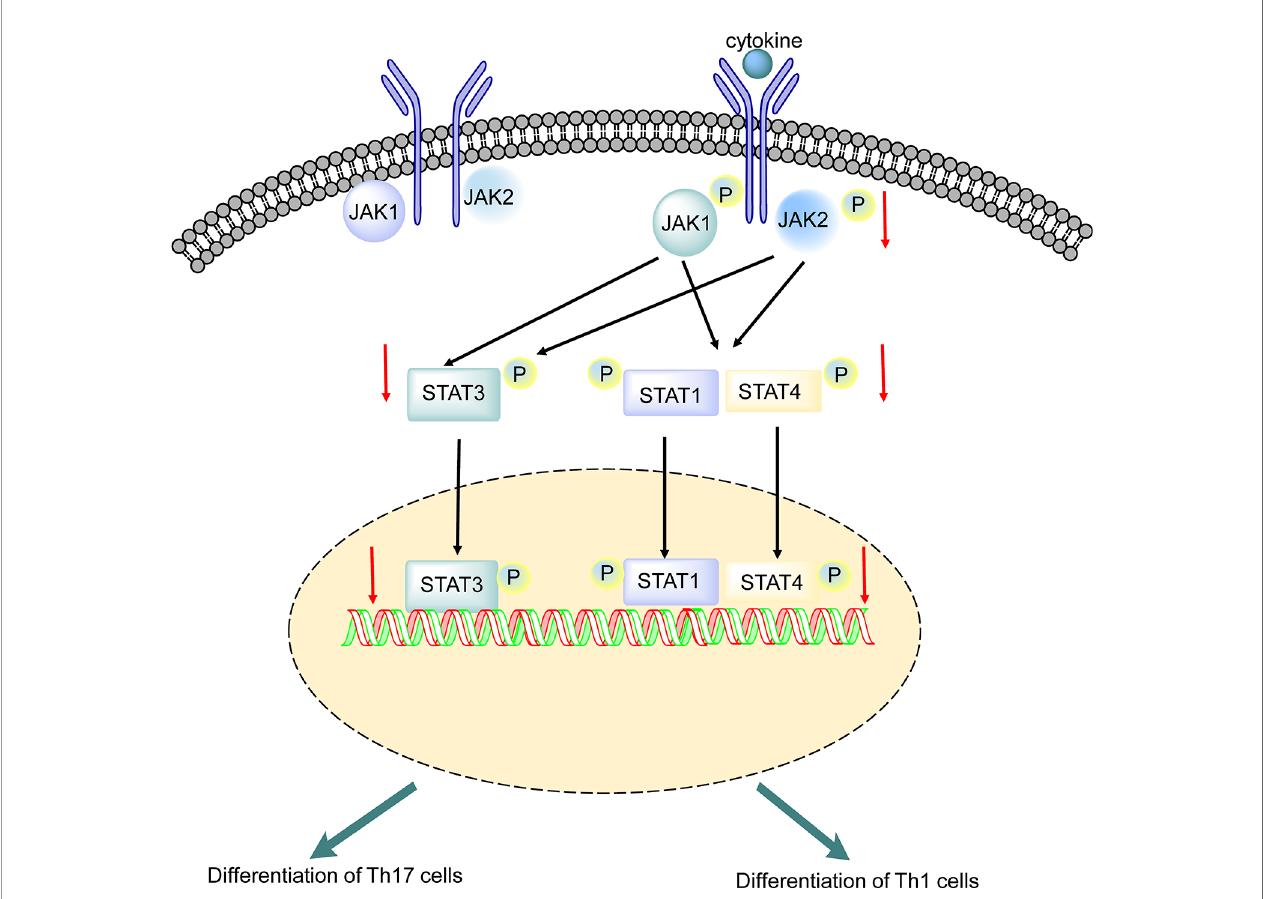
FIGURE 8 | Putative mechanism underlying the effect of baricitinib on experimental autoimmune encephalomyelitis (EAE). Phosphorylation of receptor chains by JAKs is induced by cytokine binding. STAT1, STAT3, and STAT4 are phosphorylated by JAK1 and JAK2, leading to dimerization. Baricitinib inhibited JAK1 and JAK2, leading to decreased phosphorylation of STAT1, STAT3, and STAT4. The reduction in STAT3 phosphorylation may directly inhibit Th 17 cell differentiation. The reduction in STAT1 and STAT4 phosphorylation suppresses Th 1 cell differentiation. SEM, standard error of the